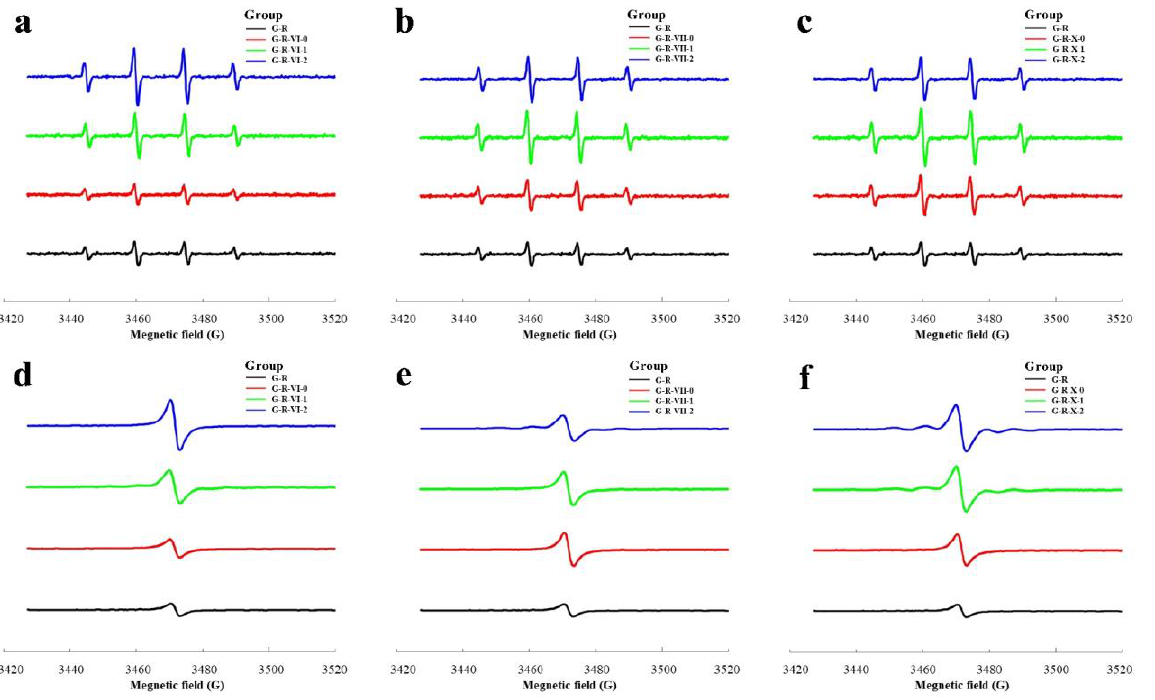
Figure 5. ESR spectra of the MRPs produced by the MR systems with different aliphatic aldehydes: ( a – c ) hydroxyl radicals and ( d – f ) DPPH of the ( a , d ) control (G-R) and the G-R-VI groups, ( b , e ) G-R and G-R-VII groups, and ( c , f ) G-R and G-R-X groups.